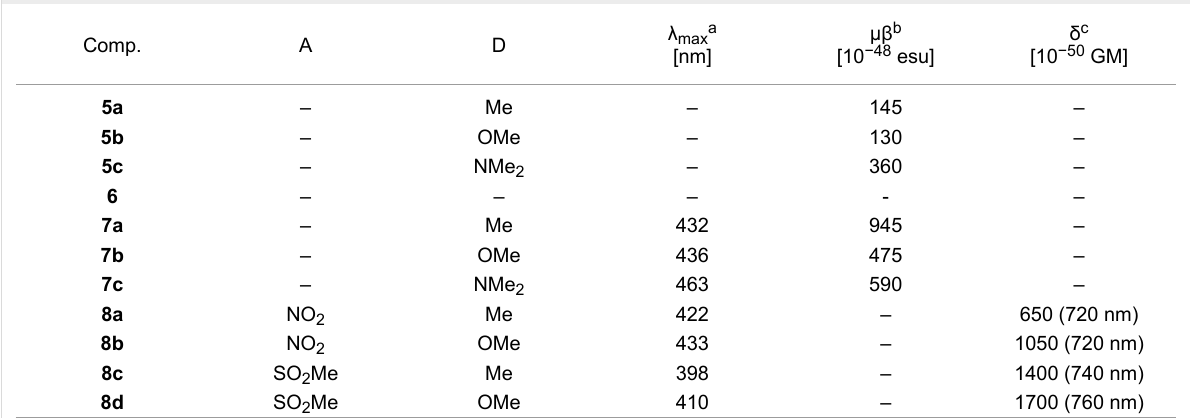
Table 2: Selected properties of chromophores 5 – 8 [33-35].